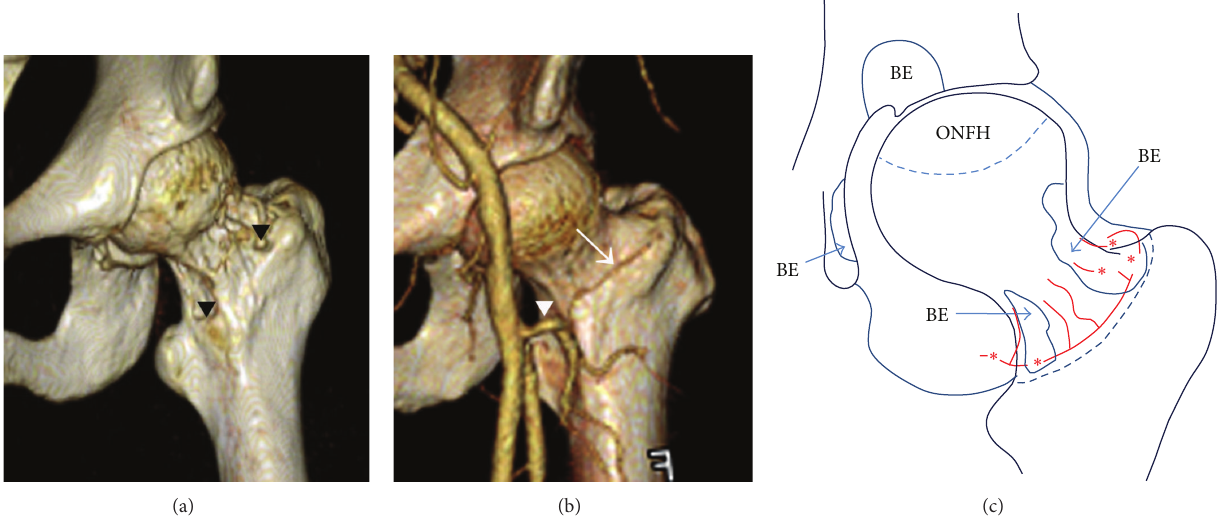
Figure 3: (a) Reconstructed three-dimensional computed tomography image shows bone erosions of the femoral head-neck junction (arrowhead). (b) Reconstructed three-dimensional computed tomography-angiography image of a normal individual. The lateral femoral circumflex artery (arrow) and base of medial femoral circumflex artery (arrowhead) are visible. (c) BE: bone erosion; ONFH: osteonecrosis of the femoral head. A schema of the BE area and ONFH. Asterisks show a break or compression of the lateral femoral circumflex artery, base of the medial femoral circumflex artery, and/or retinacular arteries. These arteries were considered to be injured by pigmented villonodular synovitis, creating multiple BE around the femoral head-neck